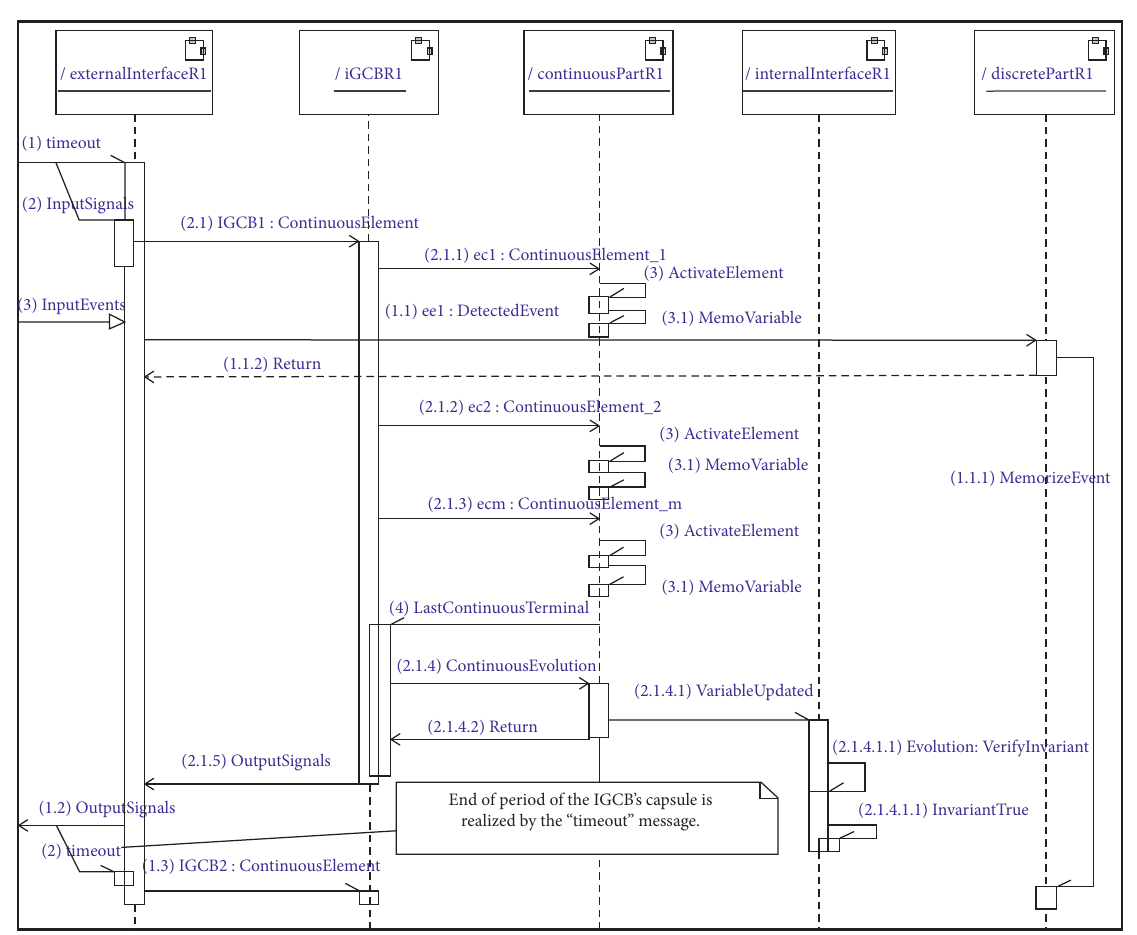
Figure 6: Sequence diagram of the real-time communication pattern for the AUV